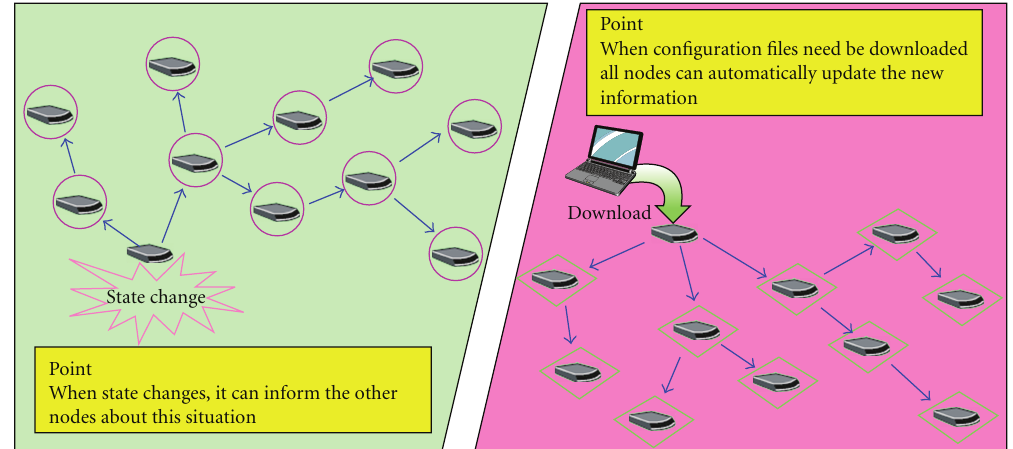
Figure 1: A multi-hop data sharing WSN.